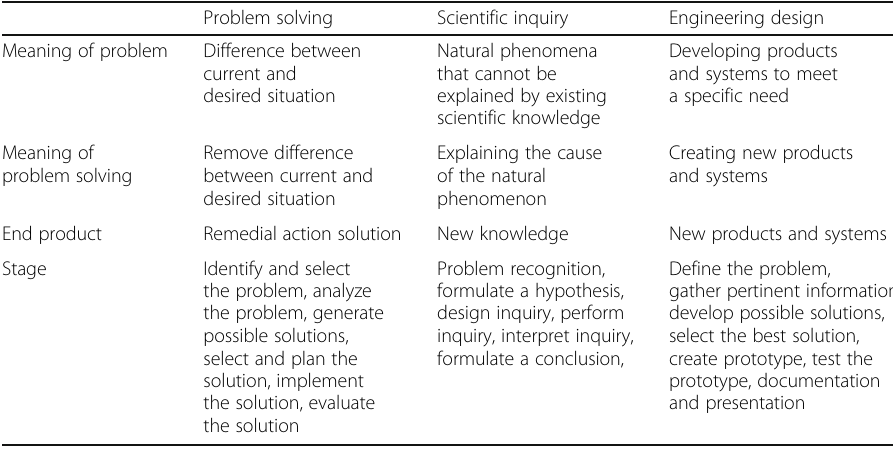
Table 2 Comparison of characteristics of problem solving, scientific inquiry, and engineering